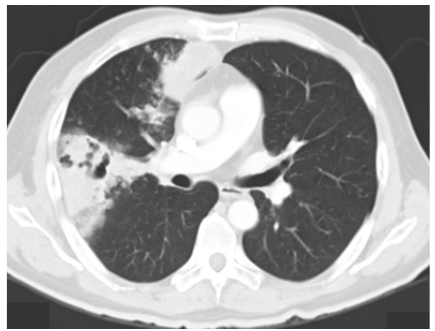
Figure 1: Axial computed tomography showing middle right lobe involvement.